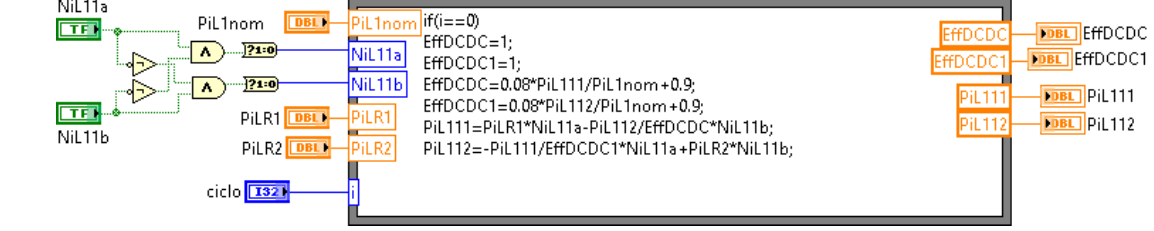
13 of 20 Figure 10. LabVIEW programming for PV generators. . Figure 11. LabVIEW programming for WT generators.